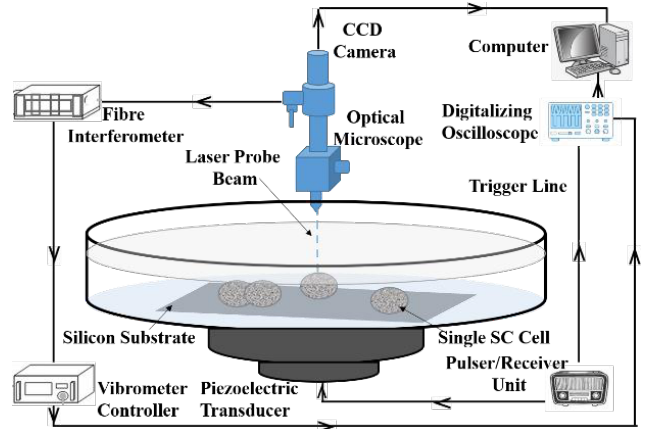
Figure 17. The instrumentation and connectivity diagram of the experimental set-up (not to scale) (CCD–Charge coupled device; SC–single cell) (Figure redrawn from [204]). (CCD–Charge coupled device; SC–single cell) (Figure redrawn from